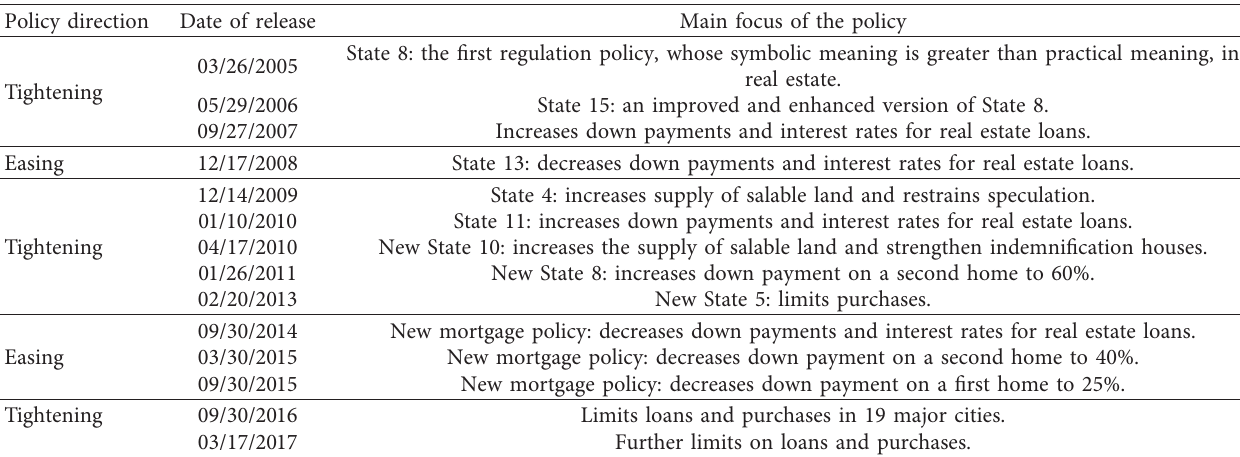
Figure 6: The low-frequency component of house prices in Beijing with some significant events. Table 6: Real estate regulations, 2005 to